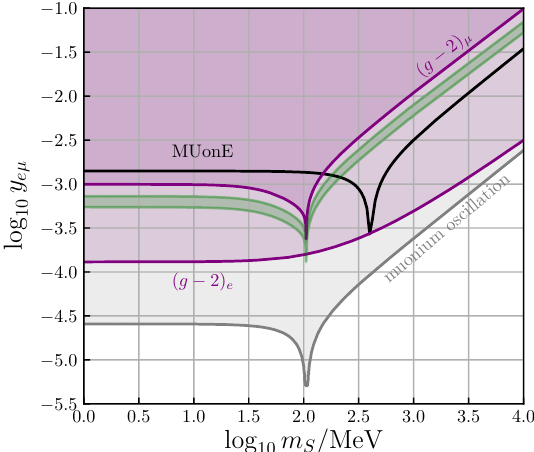
Figure 12 . MUonE sensitivity and current constraints on m gray shaded region is the muonium-antimuonium oscillation limit. The rest of the color coding is the same as in (cid:12)gure